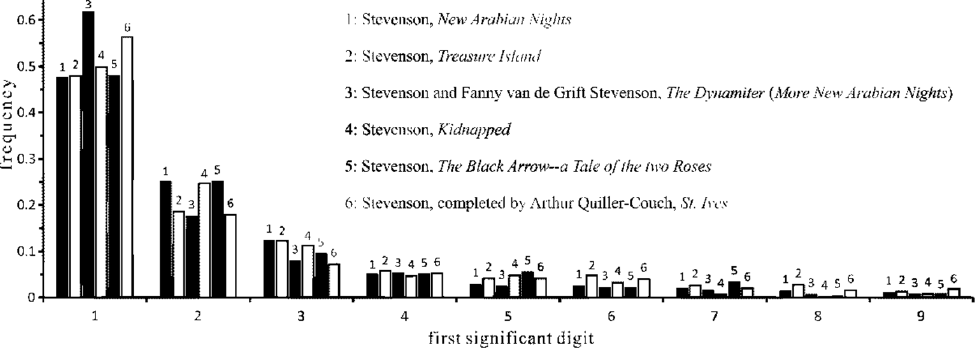
Figure 8. The distribution of the first significant digits of numerals in Stevenson’s texts. The frequency of the first significant digit 1 can reach values twice as large according to Benford’s Law (Figures 1–8).